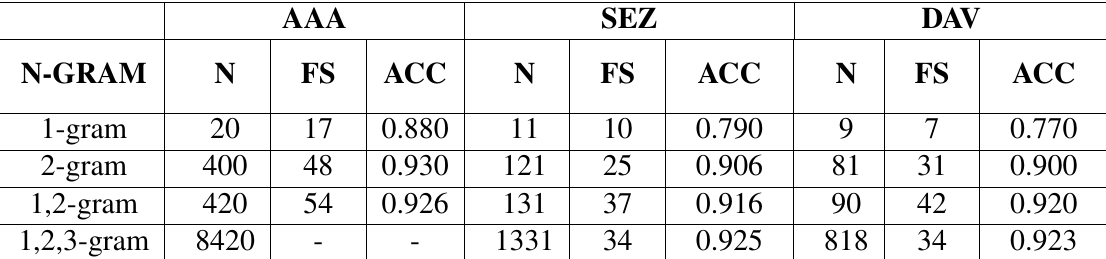
Table 3: N-gram classification results using sequential forward feature selection, for the three different alphabets.